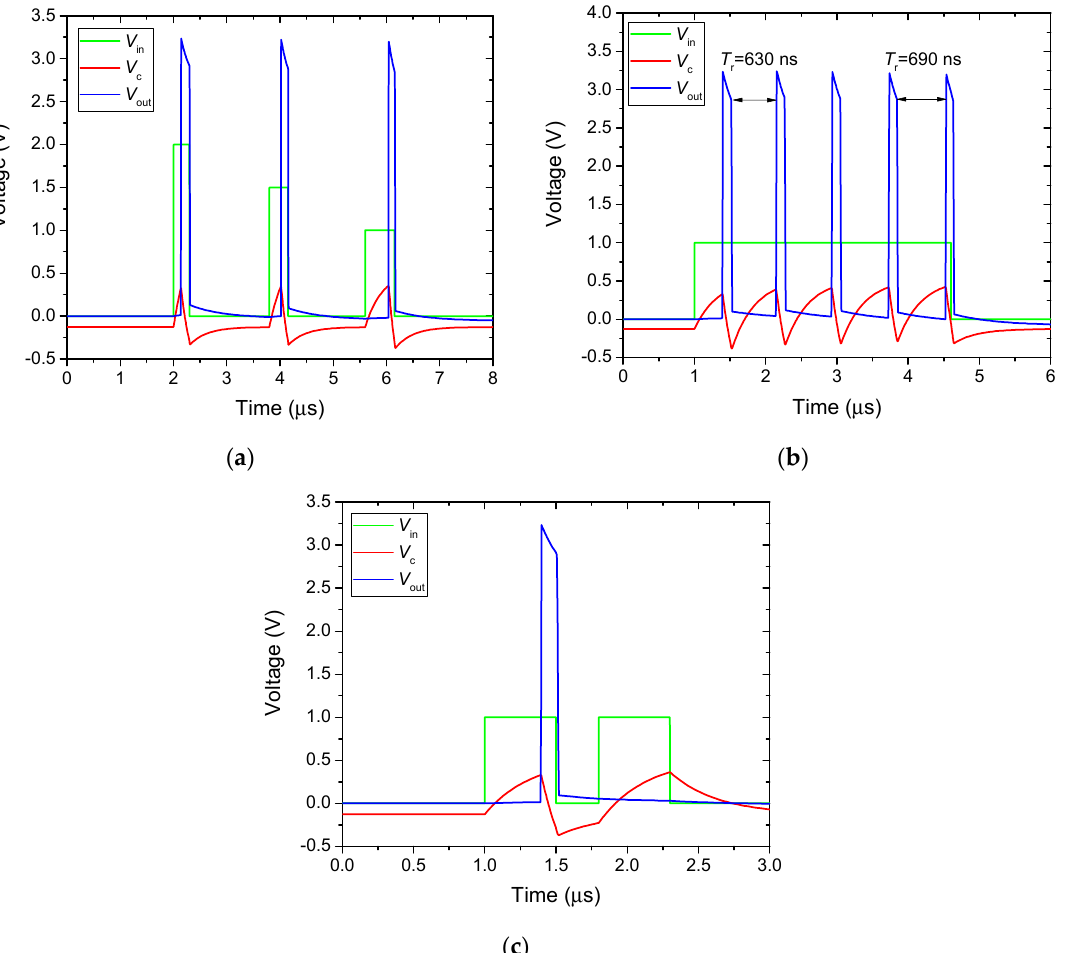
Figure 4. ( a ) Oscillograms of V in , V c , and V out , applying to the VO 2 -neuron input pulses of different duration and amplitude, ( b ) one long pulse, and ( c ) two pulses with a small delay between them. If the delay between the spikes is less than the refractory period, the neuron generates only one spike. Figure 4c demonstrates two input pulses with an amplitude of 1 V and a delay of 300 ns, and the neuron generates a spike only for the first input pulse.